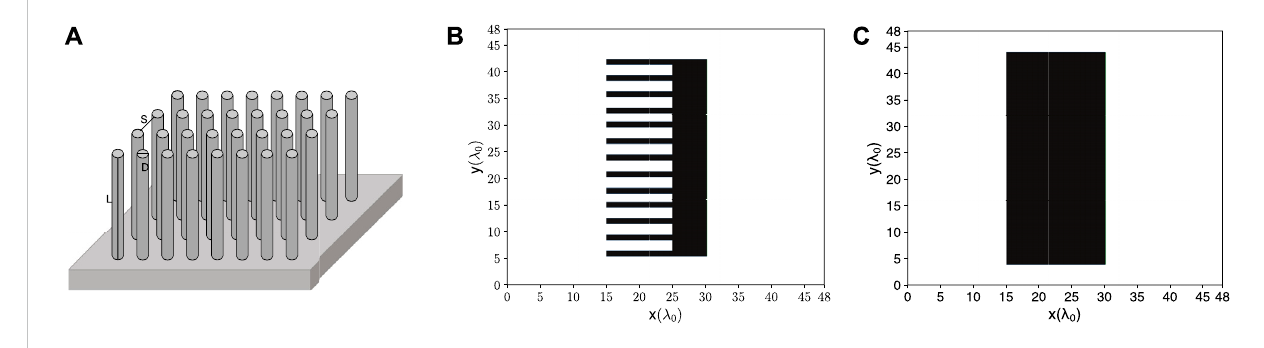
FIGURE 1 Schematic diagram of the multi-channel target (A) 3D con fi gurations. L , D , and S are the channel length, diameter, and spacing, respectively. (B) Corresponding 2D con fi gurations. (C) A fl at target 2D con fi